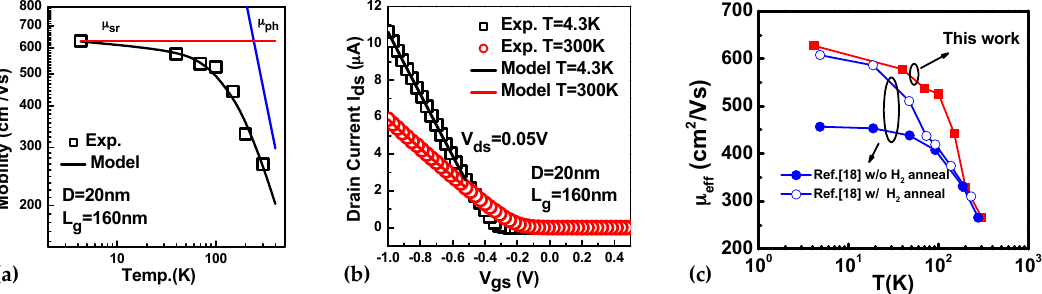
Figure 11. ( a ) The trend of mobility with temperature in GAA SNWTs; ( b ) comparison of current simulation results with experimental results of GAA SNWT at T = 4.3 K and 300 K, respectively; ( c ) effective electron mobility as a function of temperature for triangular GAA SNWT achieved by TMAH wet etching and quadrate SNWT with/without H 2 annealing.